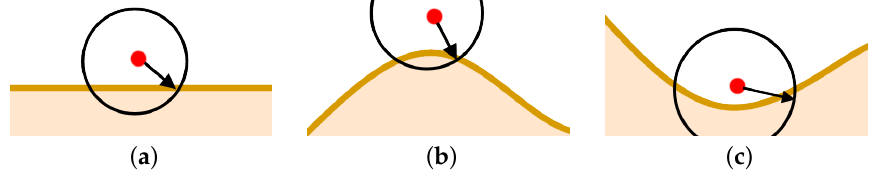
displacements; various shapes of boundaries ( a ) flat; m